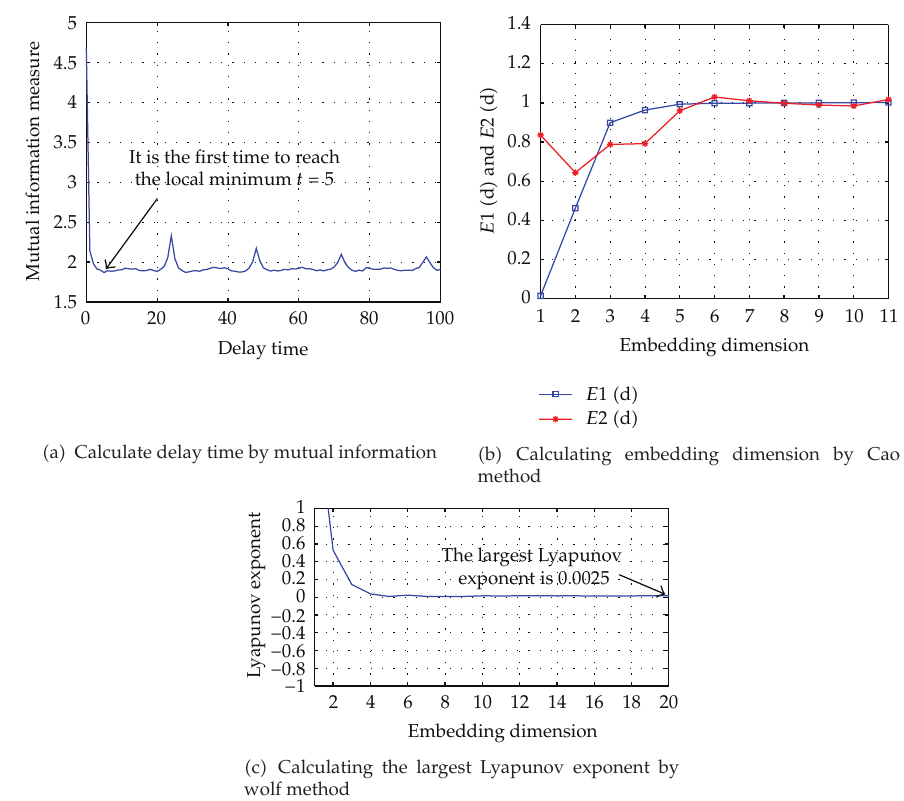
Figure 4: The graphics of the three